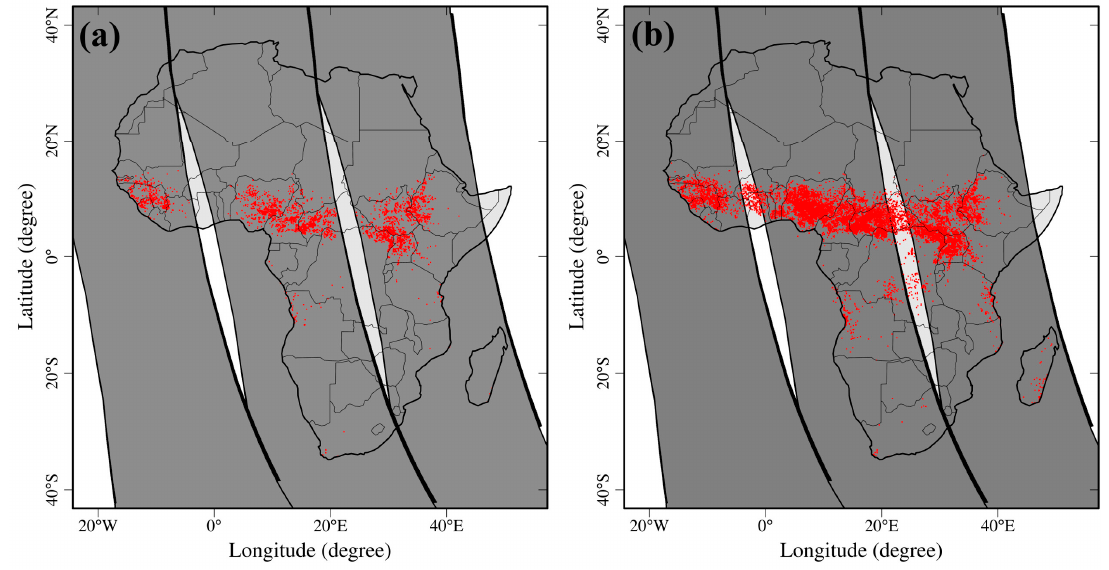
Figure 2. Daytime active fire detections from Aqua MODIS ( a ) and Suomi National Polar-orbiting Partnership (S-NPP Visible Infrared Imaging Radiometer Suite (VIIRS) I-band ( b ) on January 16, 2017. The shading areas show areas observed by MODIS in three consecutive Aqua orbits across Africa. Note that VIIRS observations have full coverage and the gaps from MODIS are added in ( b ) for comparison purpose.